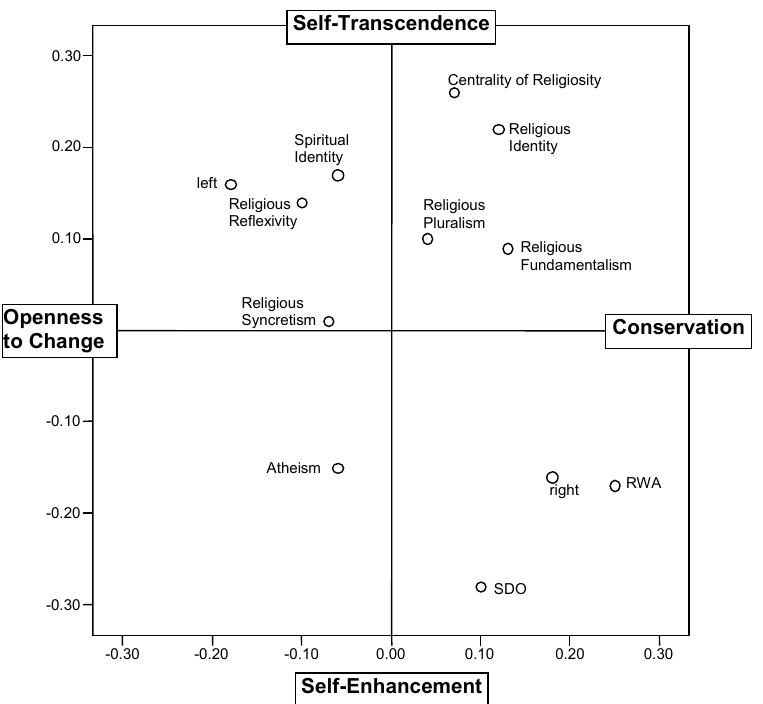
Figure 2. Correlation plot of the religiosity scales with the two dimensions of the value circle.